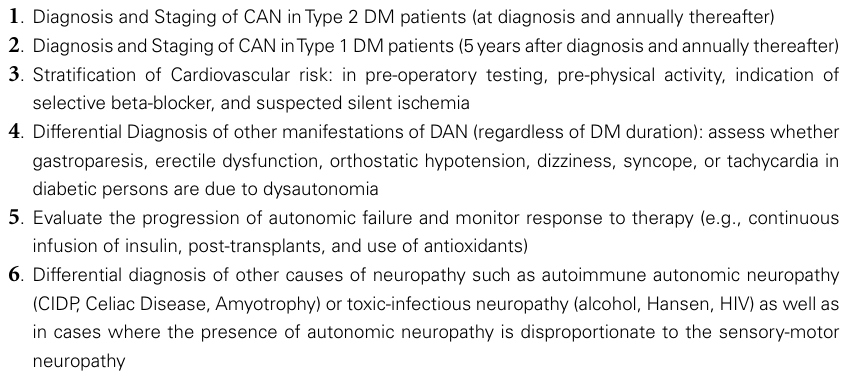
Table 1 | Indications for the cardiovascular autonomic reflex tests (CARTs)* . 1 . Diagnosis and Staging of CAN inType 2 DM patients (at diagnosis and annually